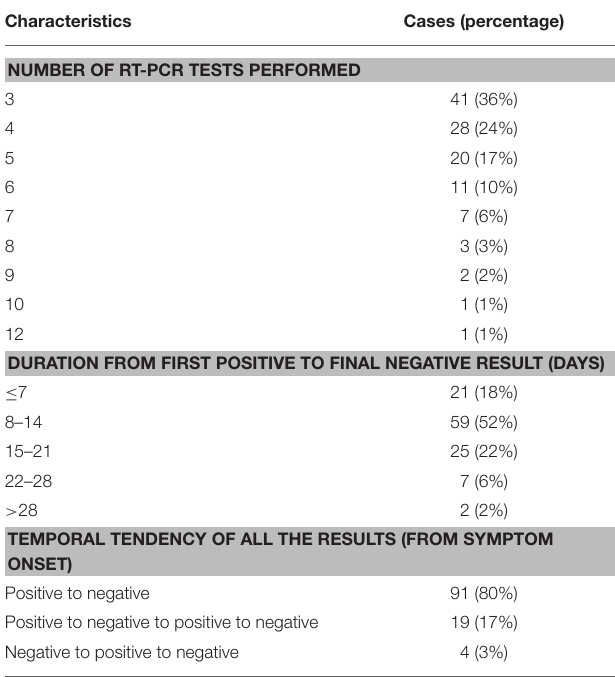
TABLE 4 | Characteristics of RT-PCR test in 114 pediatric